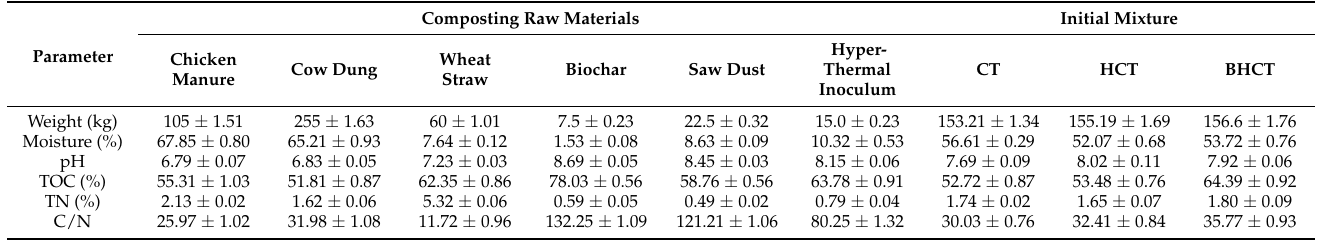
Table 1. The main physicochemical properties of the raw materials, CT, HCT, and